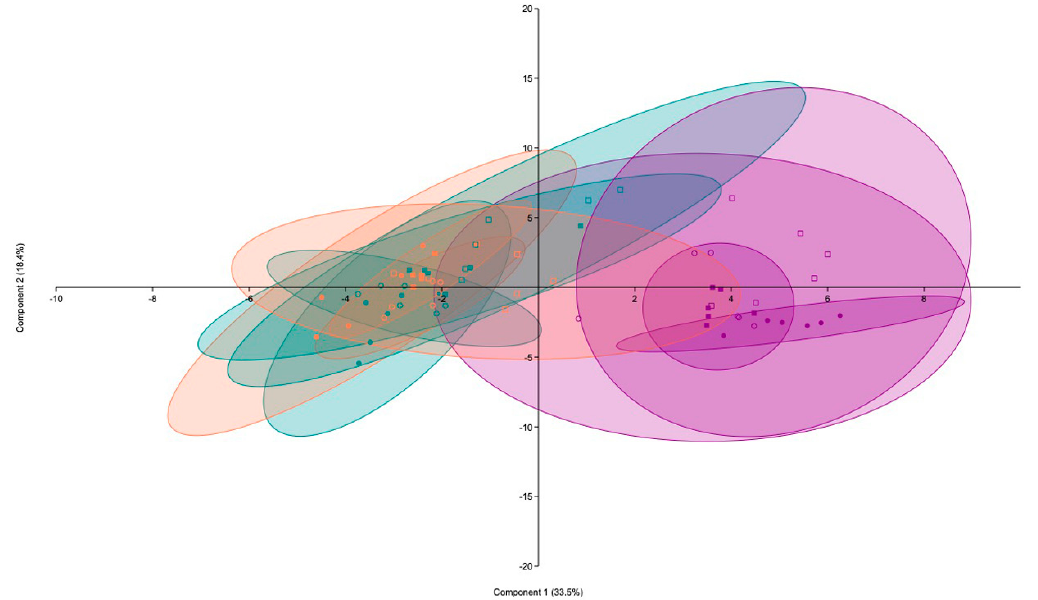
Figure 1. Principal components analysis (PCA) for data corresponding to the ammonium experiment. Plot with data run in PAST software, showing the two principal components (PC1 and PC2) which separated the samples by ammonium level. Blue color corresponds to no N treatments, orange color correspond to low N treatments and purple color to high N treatments. Solid circles represent non-AM plants under WW, solid squares represent non-AM plants under DS (during 14 days), empty circles represent AM plants under WW and empty squares represent AM plants under DS.